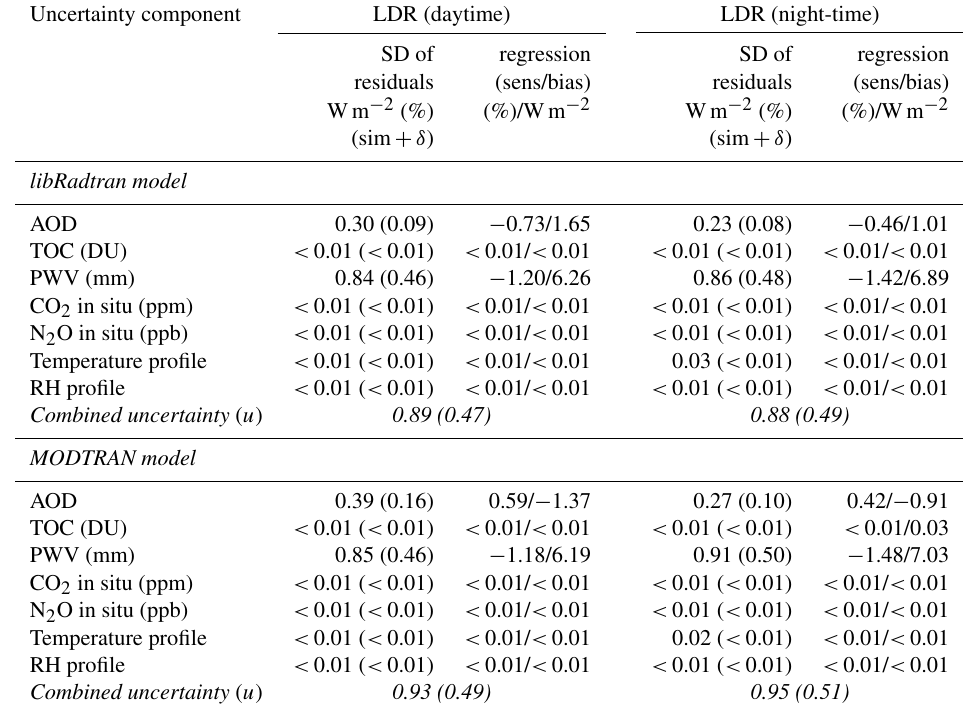
Table 3. Estimation of type A uncertainties – in Wm − 2 and in % (in brackets) –, sensitivity (%), and bias (Wm − 2 ) of the difference between non-perturbed and perturbed LDR simulations (simulation − (simulation + δ )) with libRadtran and MODTRAN models. The combined uncertainty is calculated as the root square sum of all the uncertainty